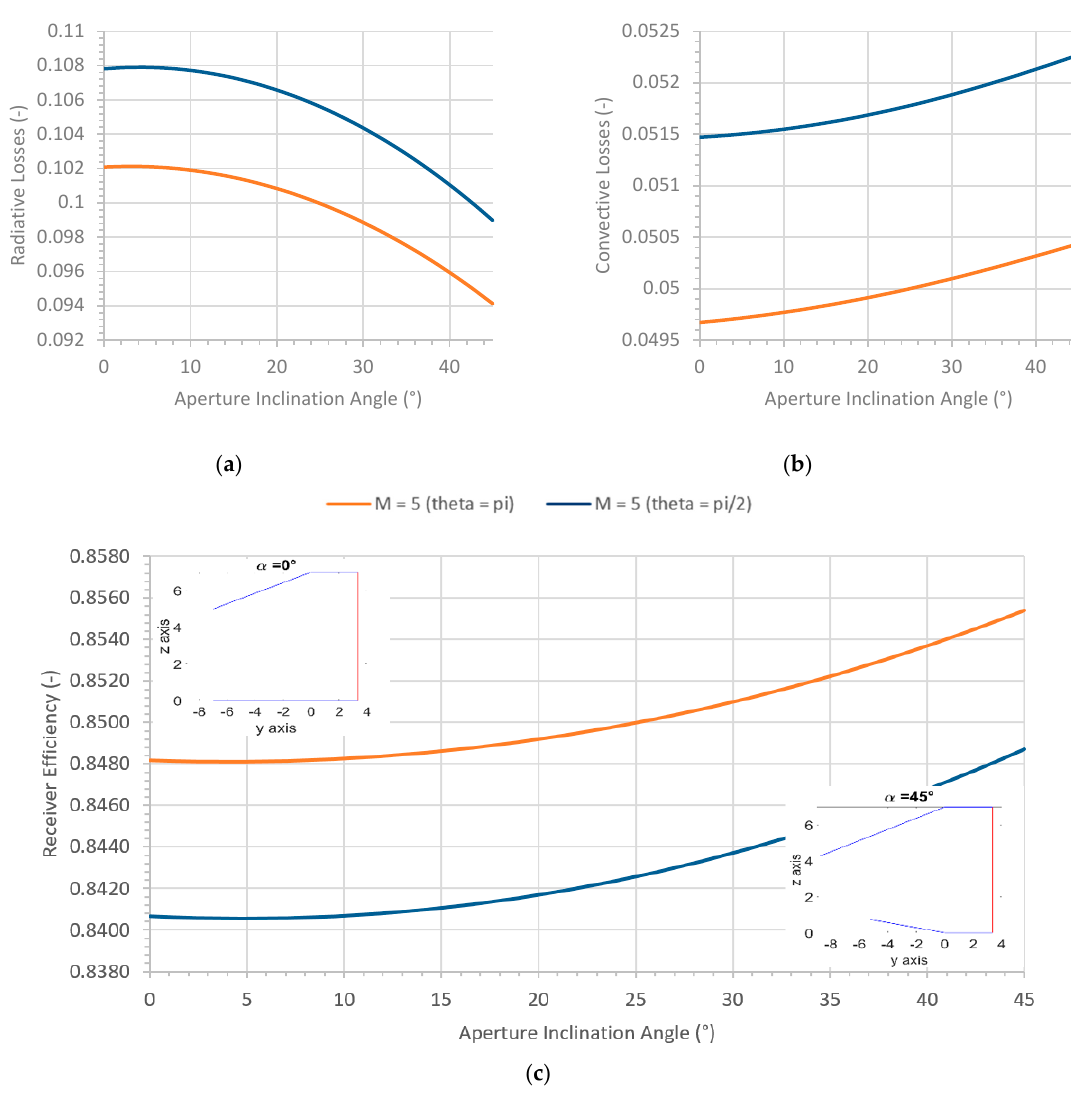
Figure 7. Influence of the aperture inclination on the radiative ( a ) and convective losses ( b ), both normalized by the receiver power, and on the receiver efficiency ( c ), for the following parameters: M = 5 panels, d ape = 7 m, L ape = 4 m and H ape = 5 m.